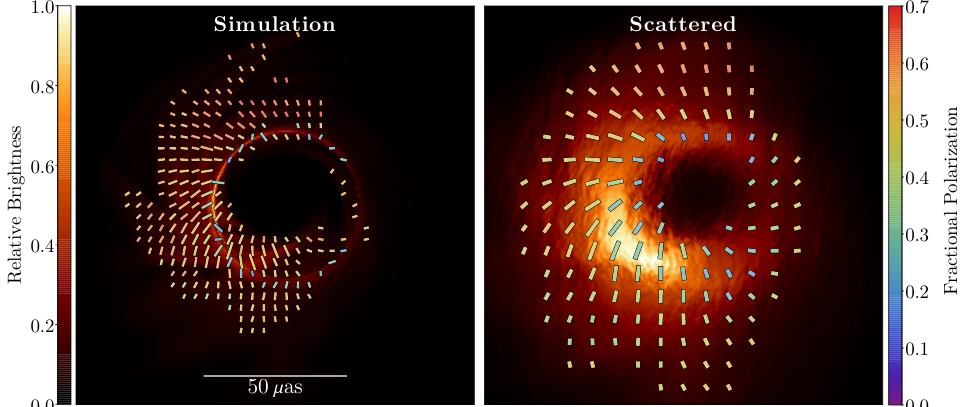
Figure 6. GRMHD model of Sgr A* at 230GHz before ( left ) and after ( right ) including the effects of interstellar scattering. This simulation is a MAD with a • = 0.7, R high = 20, and i = 30 ◦ . The background image shows total intensity with respect to the image peak, while the ticks show the polarization magnitude and direction, colored by fractional polarization, while scattering severely affects the image, key polarimetric measures are nearly immune to scattering. For example, the unresolved fractional polarization is 10.5% before scattering and is 10.6% after scattering. Likewise, the β 2 mode in polarization [55] has | β 2 | = 0.40 and arg ( β 2 ) = 52.1 ◦ before scattering, and | β 2 | = 0.37 and arg ( β 2 ) = 51.0 ◦ after scattering.